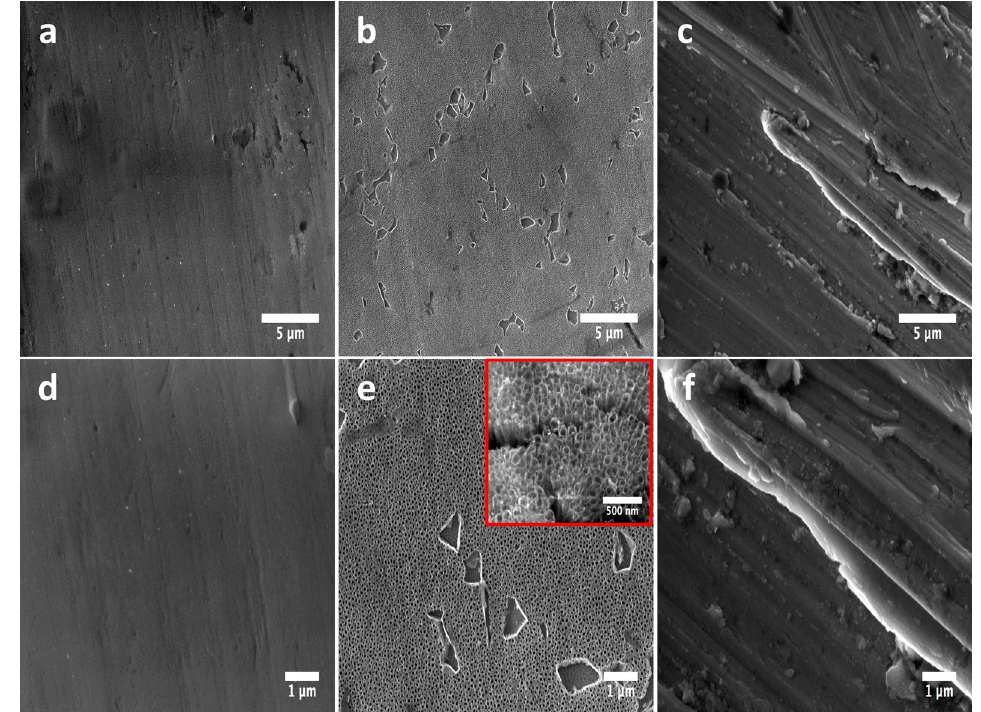
Figure 1. FE-SEM micrographs illustrating the surface morphology of the experimental materials: ( a ) Flat-Ti6Al4V surface showing a flat and smooth surface; ( b ) anodized 80 nm nanotubes (NTs) highlighting the homogenous formation of a nanostructured layer; ( c ) Rough-Ti6Al4V surface presenting irregular grooves among the material; ( d ) high zoom of the flat surface demonstrating the non-presence of a nanostructured surface; ( e ) high amplification of the NTs confirming the nanotubular homogeneity (inset represents a superior magnification, which described the nanotubular morphology); ( f ) high magnification of the rougher surface.